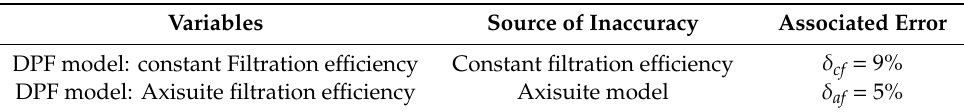
Table 6. Sensor model variables and associated